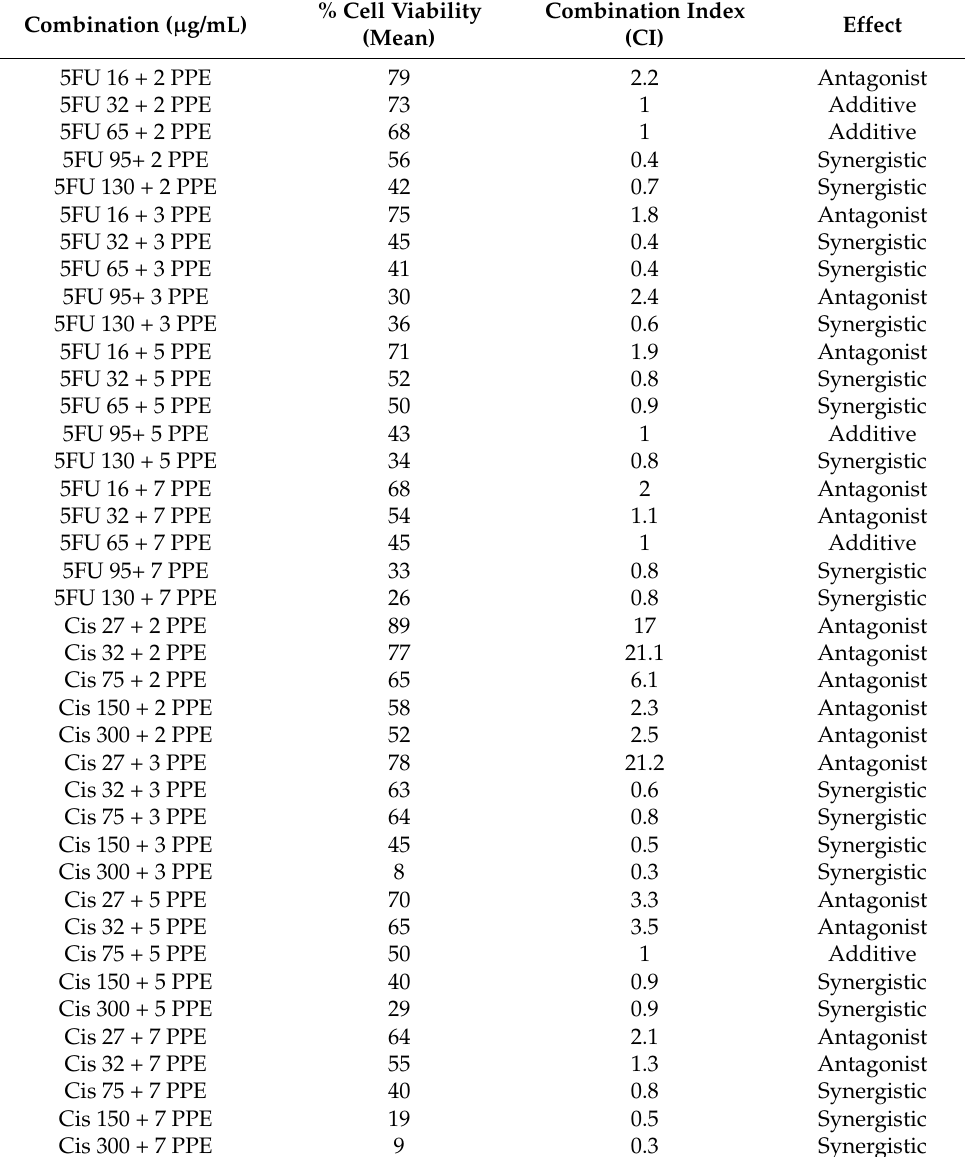
Table 3. Combinational indices of 5FU and cisplatin with PPE at different doses, % cell viability, and the subsequent effects on